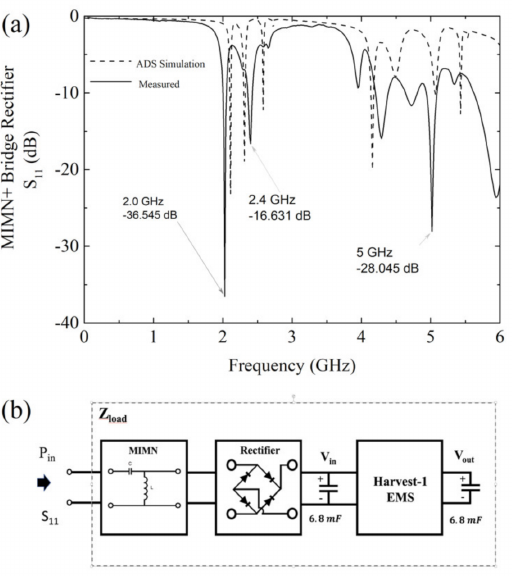
Figure 3. ( a ) Measured and simulated S 11 parameter of the MIMN connected with the bridge rectifier Z Load for Pin = − 15 dB. ( b ) Scheme of the measurement